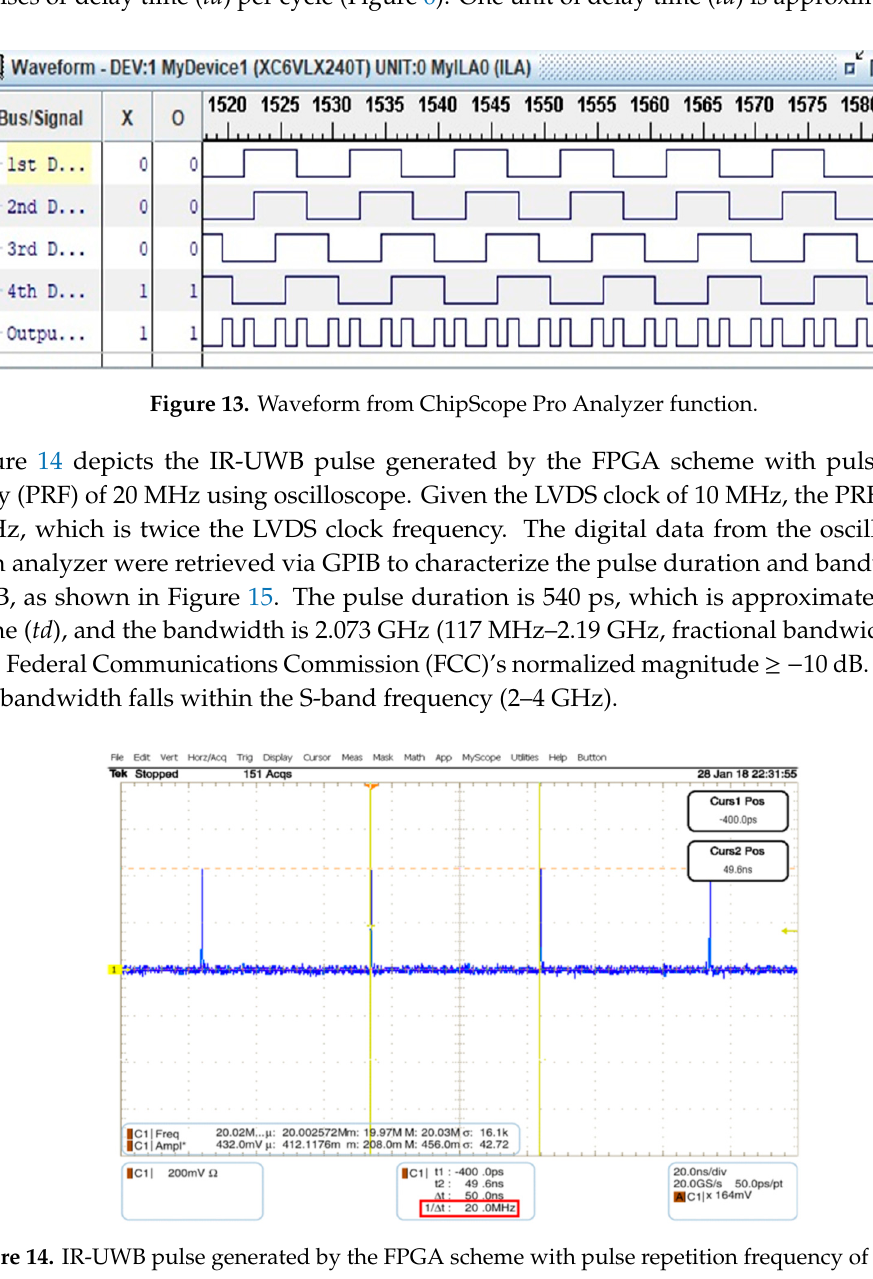
Figure 14. IR-UWB pulse generated by the FPGA scheme with pulse repetition frequency of 20 MHz using digital oscilloscope.